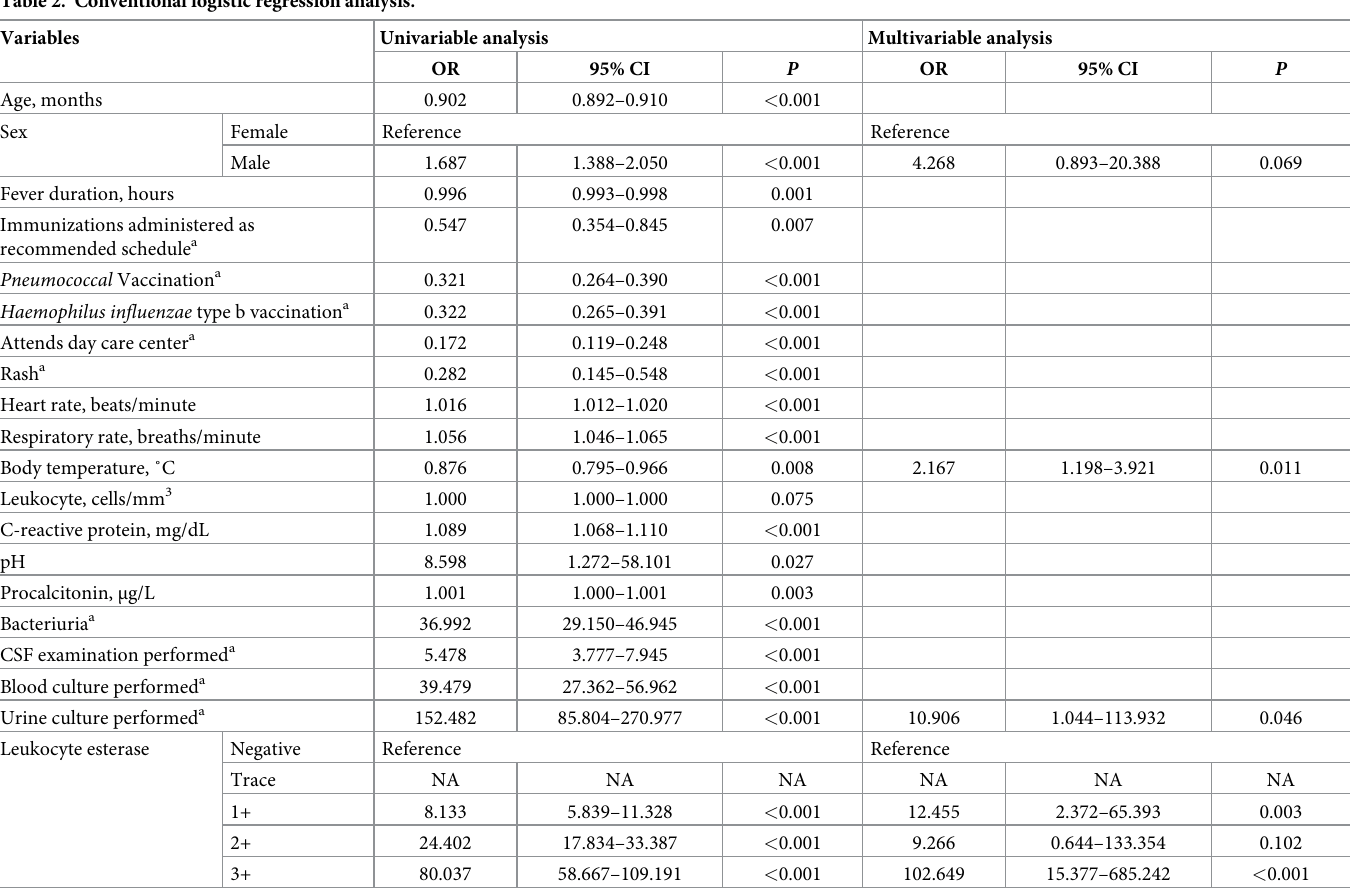
Table 2. Conventional logistic regression